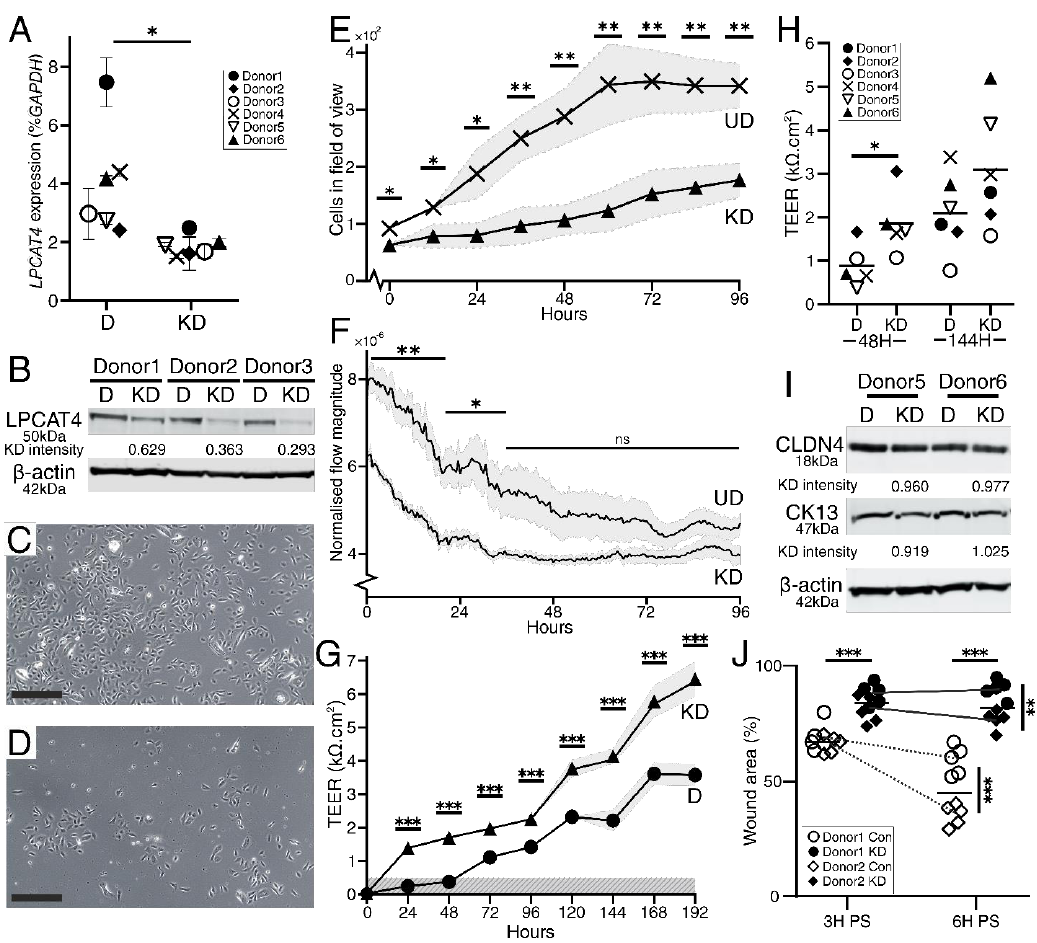
Figure 3. Characterisation of the LPCAT4 knockdown [KD] cell lines compared to control undiffer- entiated [UD] or differentiated [D] cells. Donors exhibited variation in LPCAT4 native expression as well as knockdown efficiency ( A ), but transcript-level knockdown was observed in all lines to an average of 50%. Similar knockdown was observed at the protein level ( B ). Transduced control cells ( C ) grew well, but matched LPCAT4 knockdown cultures ( D ) showed reduced population size after 9 days under transgene- selective conditions. Scale bars equal 200 μm. Reduced proliferation ( E ) and motility (normalised velocity assessed by optical flow) ( F ) were confirmed quantitatively using timelapse imaging. A significant difference in population size was even observed following the overnight acclimatising period from identical seeding densities, before recording began (0 h) ( E ). LPCAT4 knockdown cultur es consistently generated elevated ‘tighter’ electrophysical epithelial barriers [ G ]. Again, donor NHU backgrounds exhibited barrier variance with and without knock- down, but the barrier was significantly elevated across all six donors at both early (48 h) and late (144 h) differentiation time points ( H ). Knockdown did not appear to impact NHU differentiation on western blots for either early (CK13) or later (CLDN4) markers ( I ). LPCAT4 knockdown resulted in slower wound restitution after scratch wounding ( J ), but all wounds were eventually resolved. In ( A ), error bars for each donor represent the 95% confidence interval from all combinations of GAPDH and LPCAT4 technical replicates. In ( E – G ) shaded regions represent the standard deviation range around the mean line, with time-matched pairwise statistical significance indicated. *** is p < 0.001, ** is p < 0.01, and * is p < 0.05 across all plots. In ( F ), measurements were taken every 30 min, so statistical significance is represented by regions of significance based on the average p value from a 3-comparison sliding window. Wound area and closure rate was assessed using the Hoechst 33258 images, with five technical repeats by random field selection.